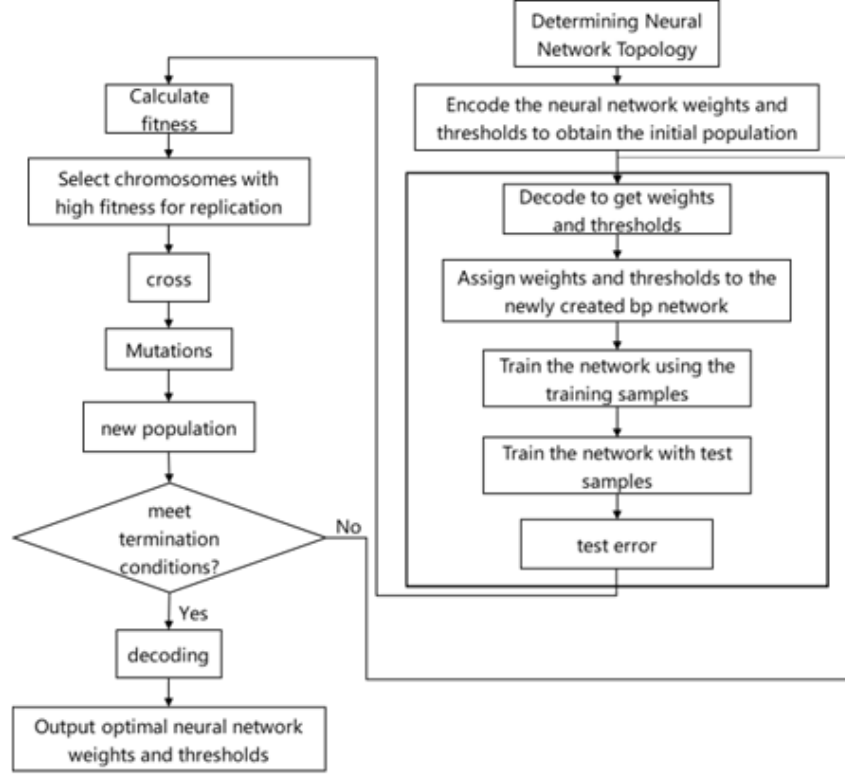
Figure 6. Basic steps of genetic algorithm optimization.